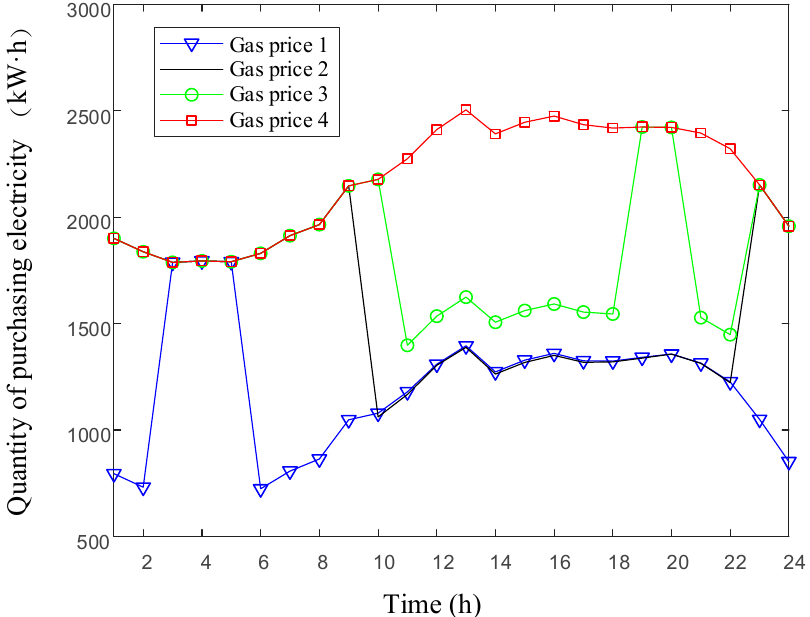
Figure 15. Quantity of purchasing electricity for different gas prices in stage 3, typical day 2.